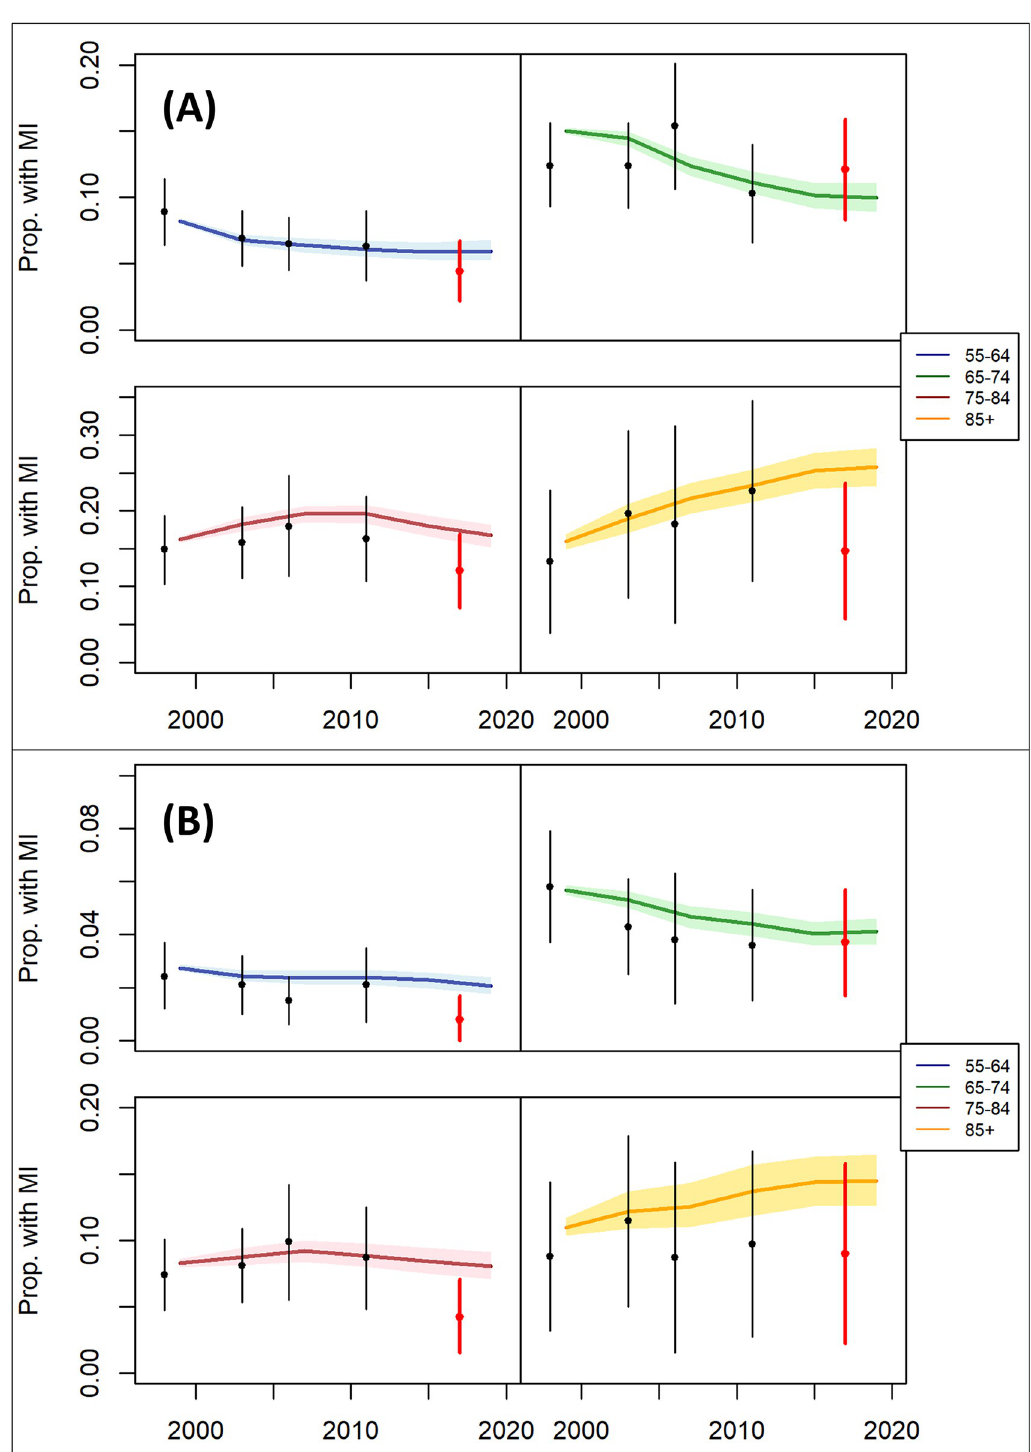
Fig 4. Validation of the model by comparison of modelled estimates of prevalence of ever having had MI with external estimates from the Health Survey for England 2017 for men (A) and women (B). Black vertical bars represent 95% confidence intervals for the prevalence of ever having had MI for 1998, 2003, 2006 and 2011, which were used in the model parameterisation process. Red vertical bars represent 95% confidence intervals for prevalence in 2017, which was not used in the model parameterisation